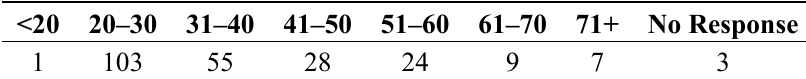
Table 1. Age distribution of respondents.